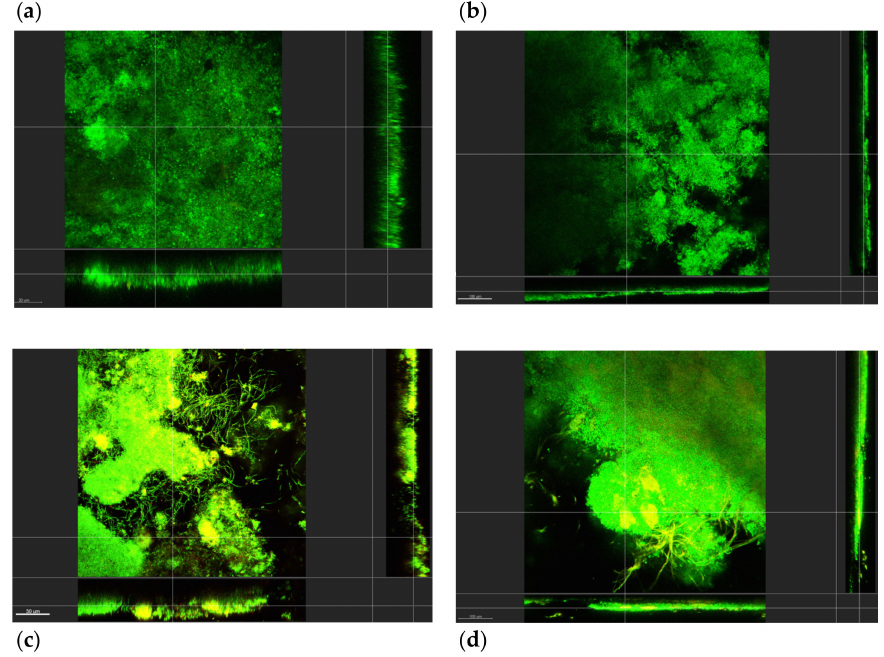
Figure 4. Confocal laser scanning microscopy images of microcosm biofilms grown on top of